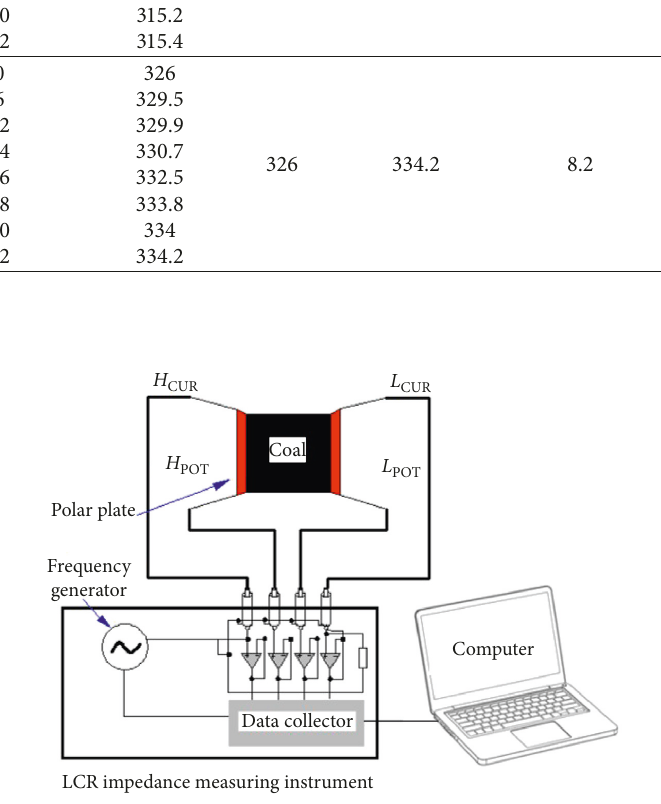
Figure 2: Schematic diagram of the four-terminal complex resistivity test device.